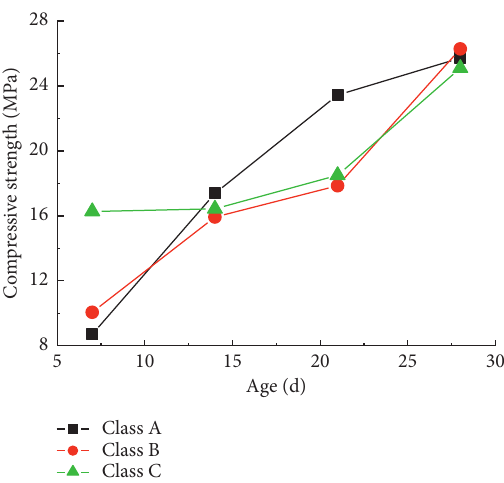
Figure 6: The curve of age-compressive strength. Figure 7: Axial strain curve of colloid cement paste samples.